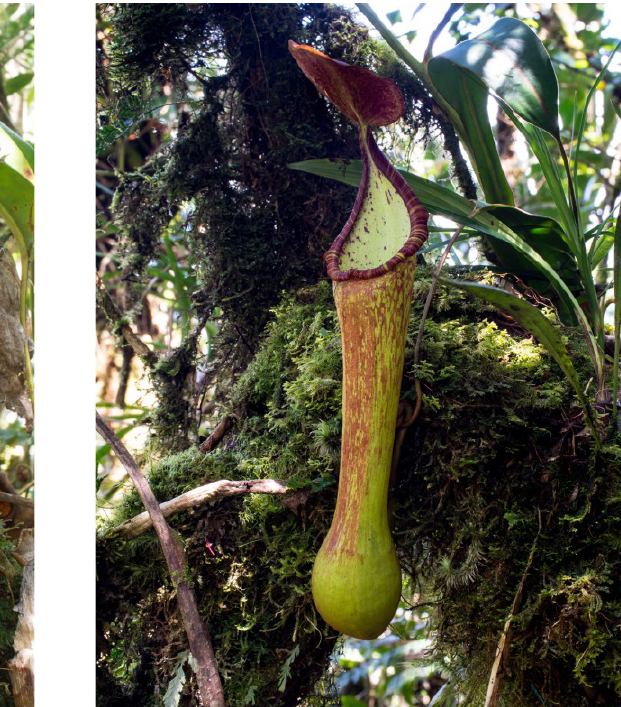
Figure A1. N. pantaronensis : photos of a lower ( left ) and upper pitcher ( right ) taken at the type